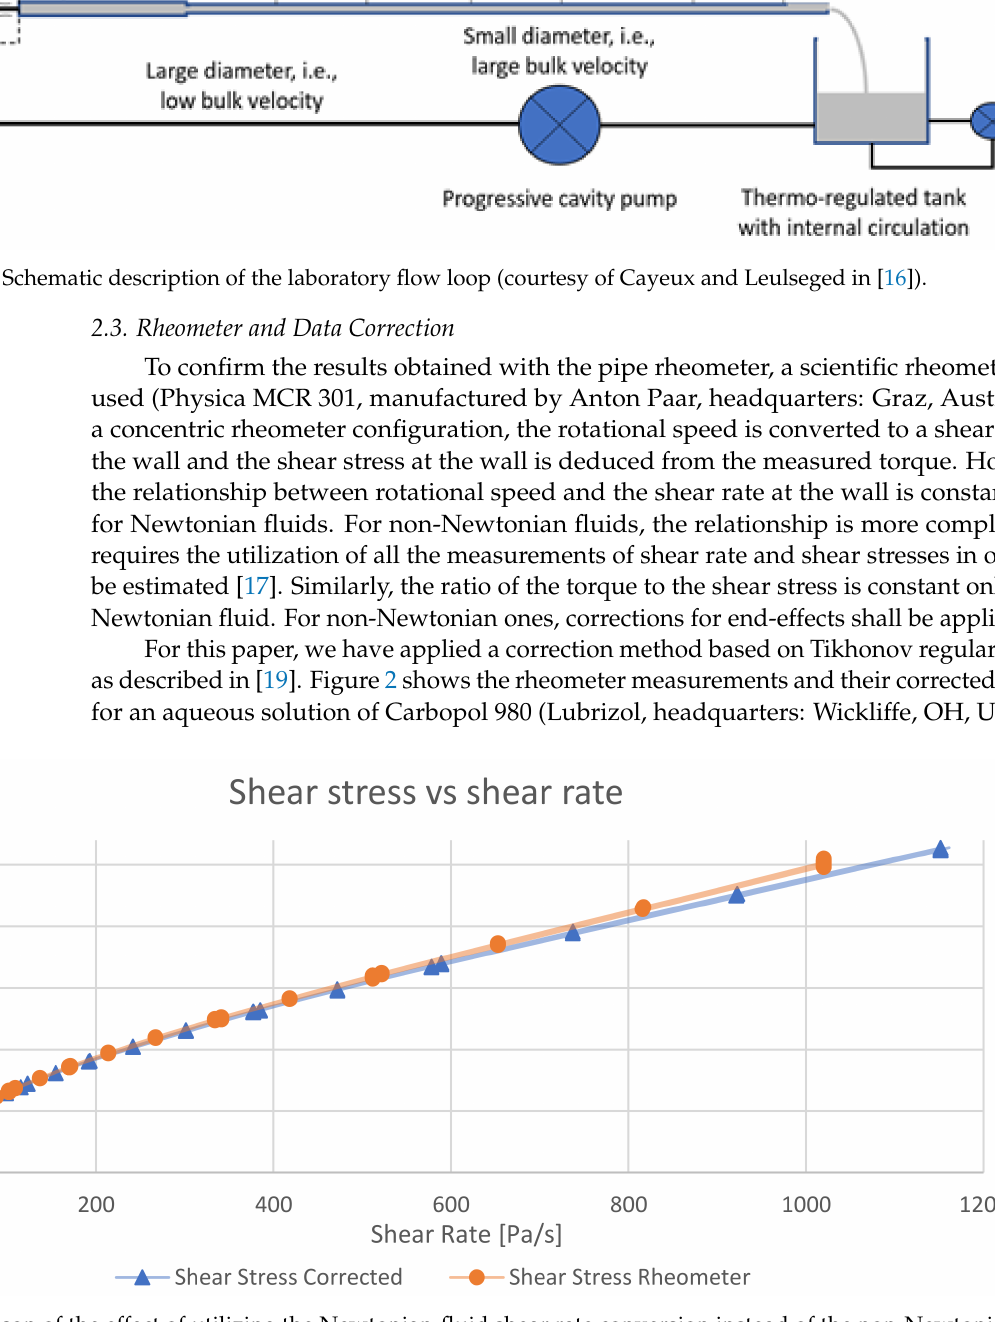
Figure 2. Comparison of the effect of utilizing the Newtonian-fluid shear rate conversion instead of the non-Newtonian shear rate conversion of the rheometer speed for a rheogram obtained with an aqueous solution of Carbopol 980 having a density of 997 kg/m 3 at 25 ◦